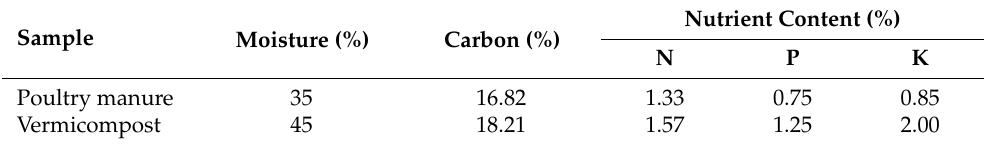
Table 6. Moisture, carbon, and nutrient content of poultry manure and vermicompost.